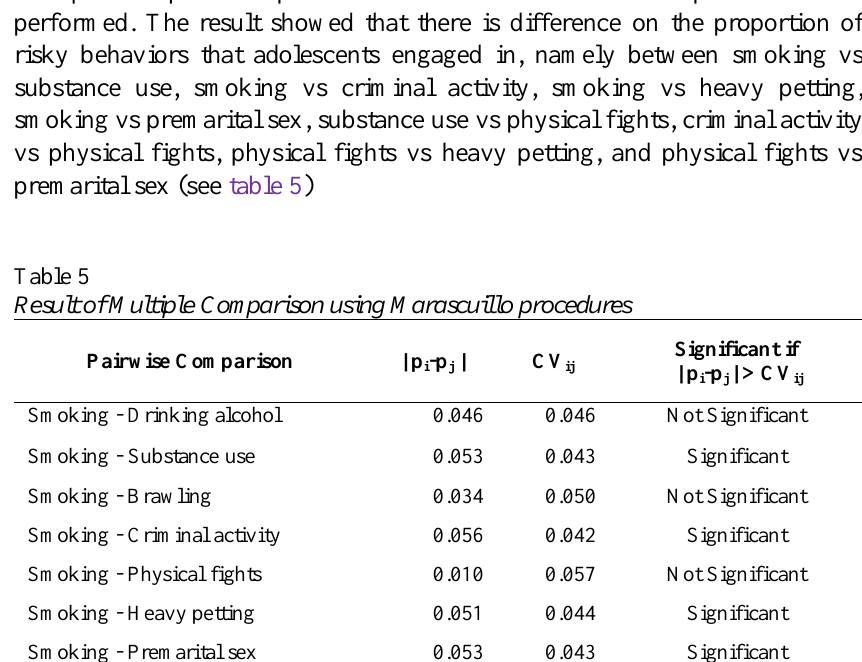
H :p =p =….p =p against the alternative hypotheses that not all eight risky o 1 2 7 8 behaviors proportions are equal, H result of Chi-Square test was 𝜒 2 = 77.016 with the p value = 0.00. This study